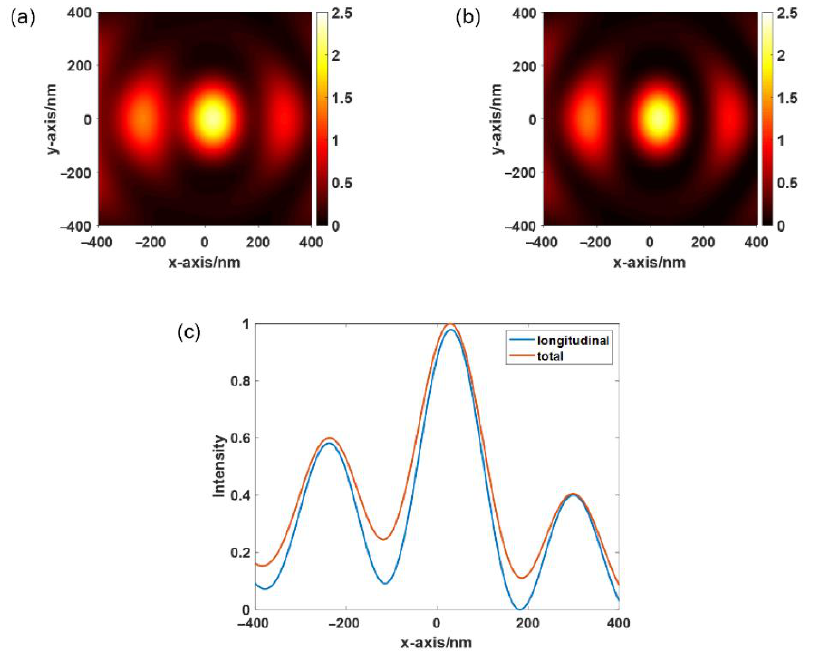
Figure 5. Distribution of ( a ) total electric field strength, ( b ) longitudinal electric field strength, and ( c ) normalized total electric field strength and longitudinal electric field strength along y = 0.